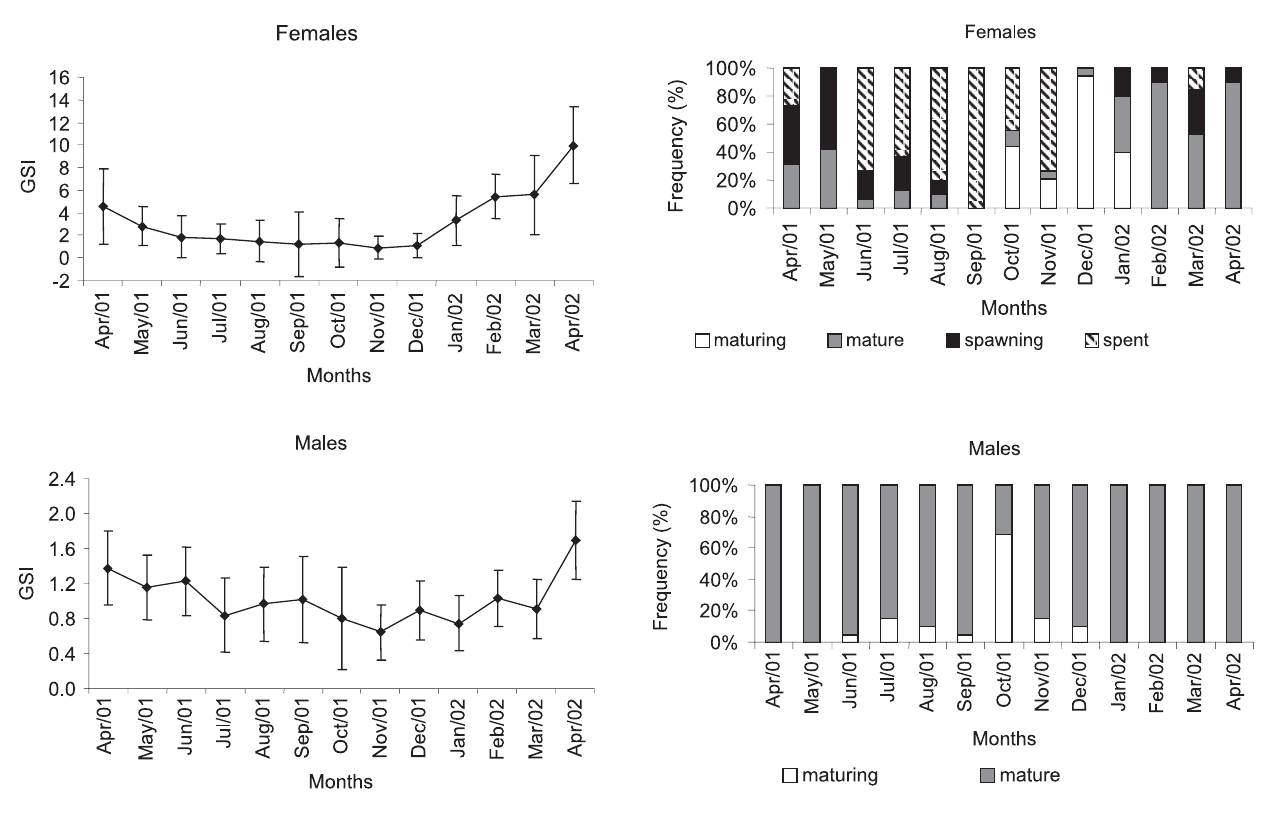
Fig. 1 . Monthly variation of the mean of the gonado- somatic index (GSI) for males and females of Serrapinnus piaba collected in the rio Ceará Mirim, from April 2001 to April 2002. Vertical bars represent the standard deviation